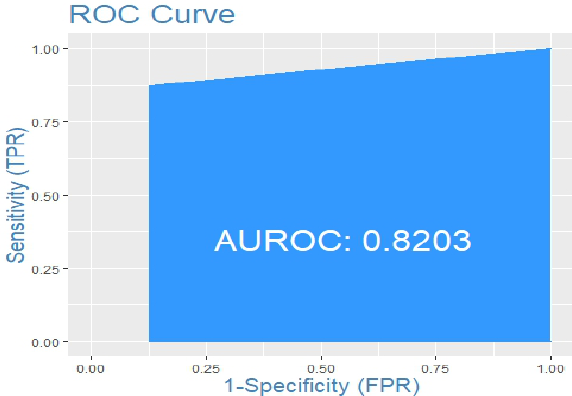
Figure 16. Area under ROC curve for DBN